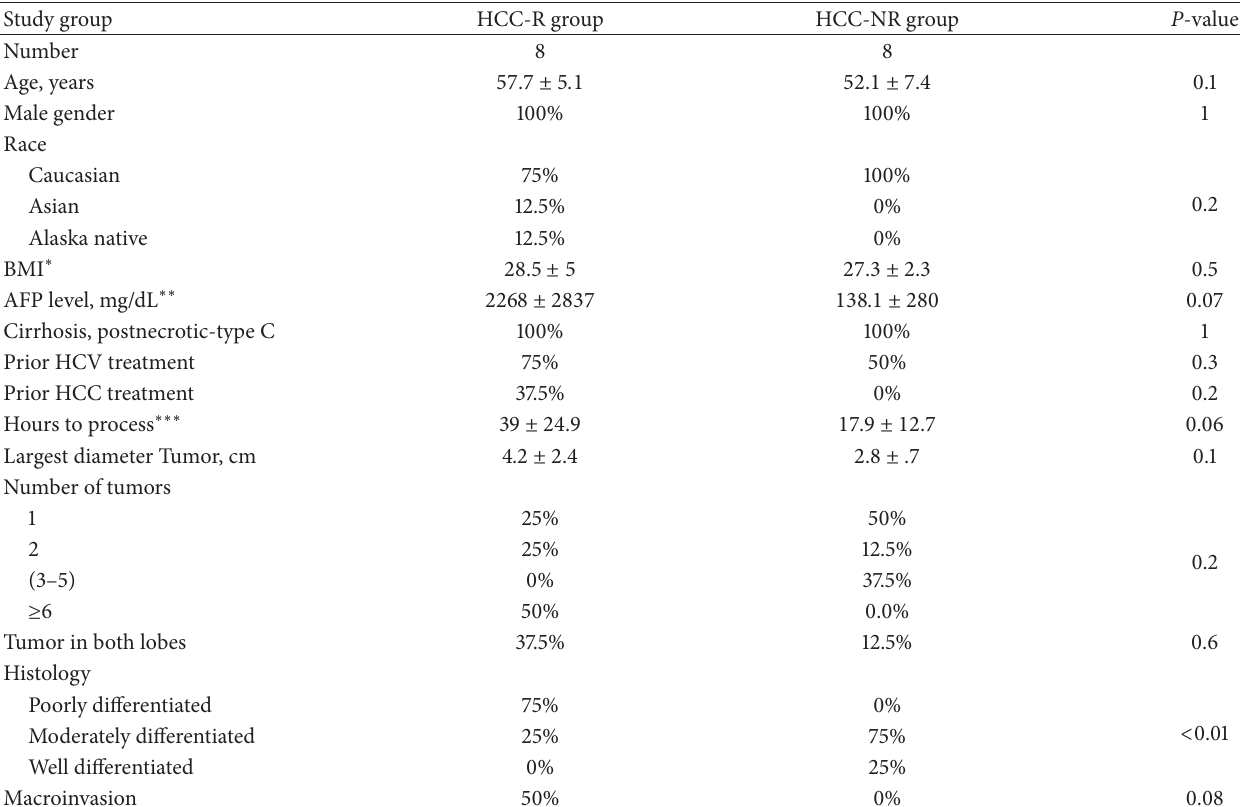
∗ Body mass index; ∗∗ alpha-fetoprotein level. ∗∗∗ Time specimens removed in surgical procedure until being fixed in formalin.